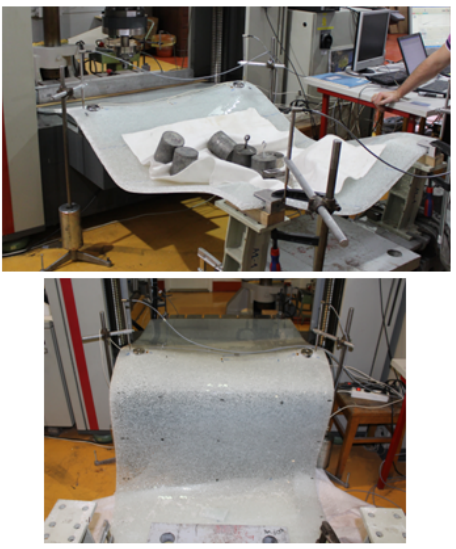
Figure 7. Breakdown of the glass railing